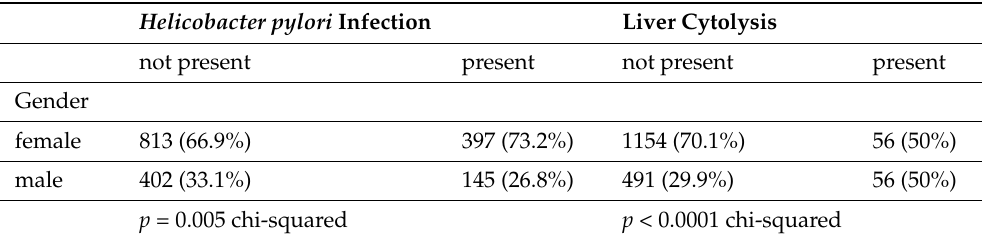
Table 2. Differences between gender-stratified subgroups.